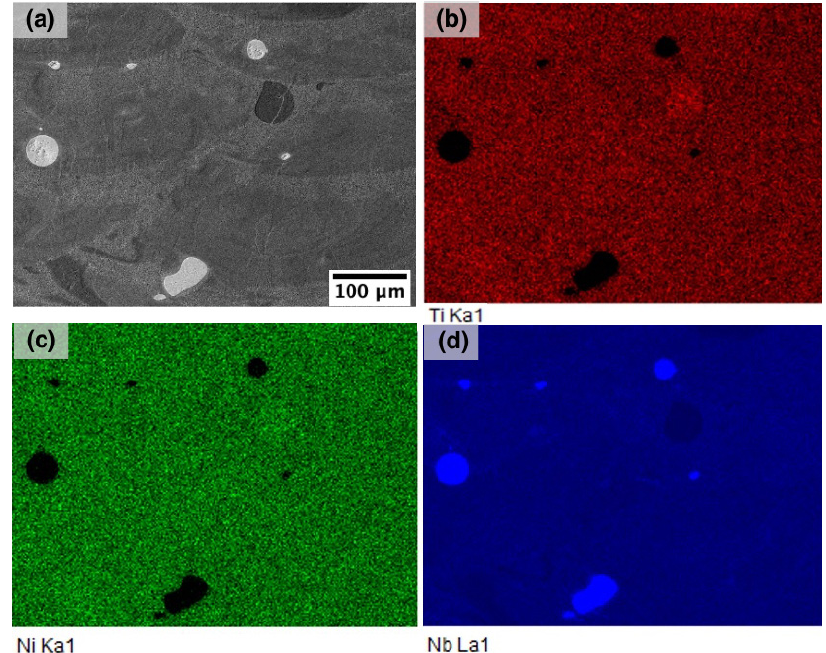
Figure 6. ( a ) SEM-image of the microstructure of E1 sample and EDS-maps showing the distribution of ( b ) Ti, ( c ) Ni, and ( d ) Nb.